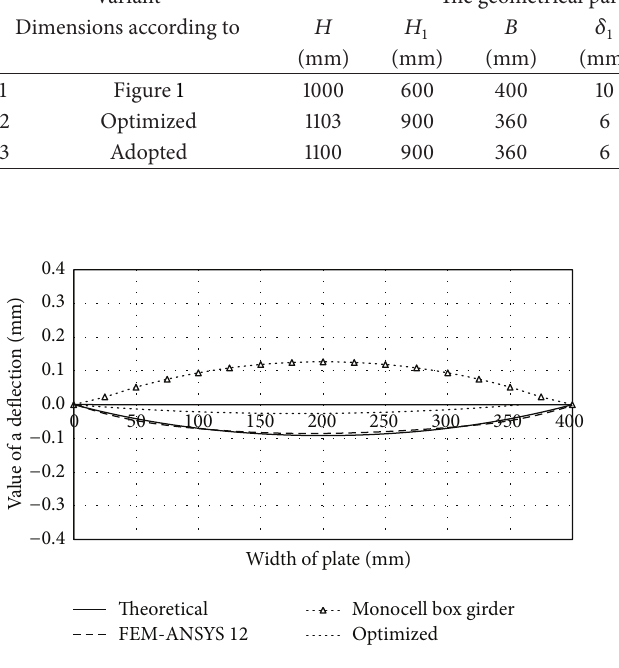
Figure 6: Comparative diagram of deflection of the girder’s lower flange plate.